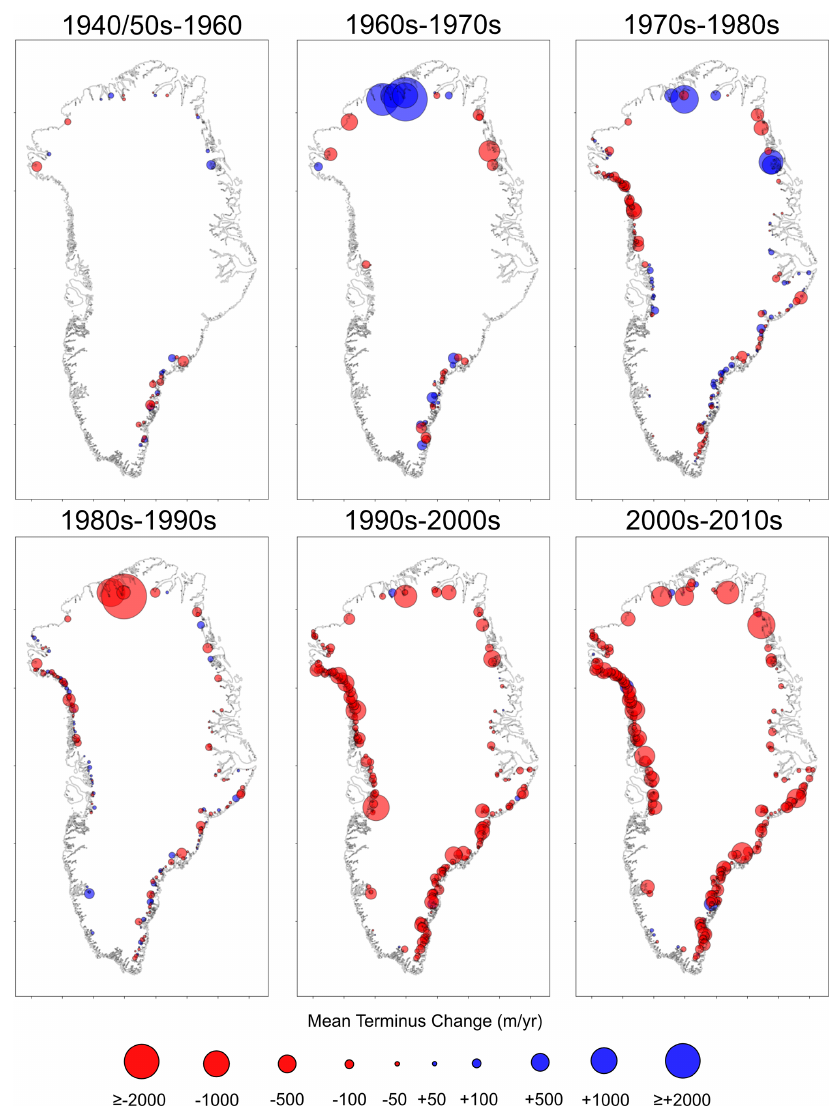
Figure 7. Decadal retreat patterns for available TermPicks data using the centerline method. For each panel, the entire decade of traces were averaged to produce an average position for that decade. The 1940/1950s are an average over both decades as there are fewer traces available in the 1950s. Then the average position for the decade is differenced from the average position of the previous decade. The size correlates to the magnitude of terminus change, while red (negative) indicates retreat and blue (positive) indicates